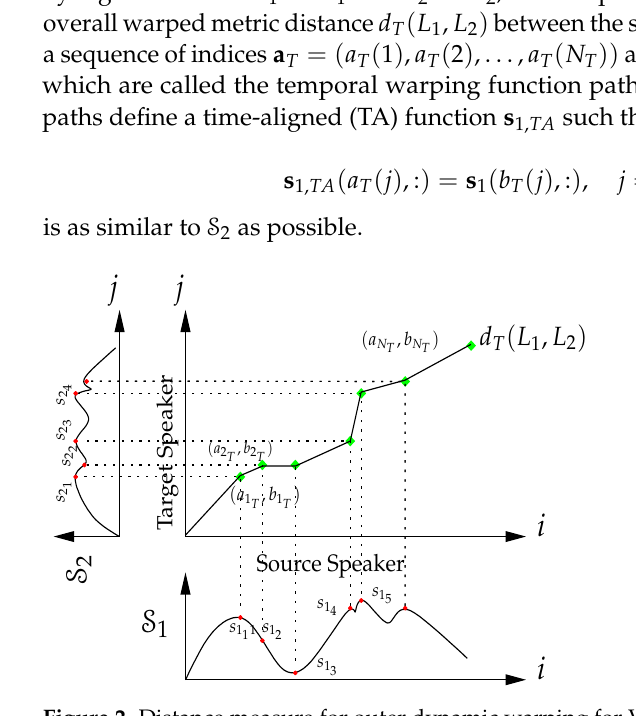
Figure 2. Distance measure for outer dynamic warping for VT. The distance between two feature vectors in (2), d ( s 1 ( (cid:96) 1 , : ) , s 2 ( (cid:96) 2 , : )) , can itself be computed using warping between the components of these individual vectors. Because these vectors represent frequency information, this is DFW. DFW is computed in a way similar to the DTW. Let s i = s i ( (cid:96) i , : ) , i = 1, 2 denote the spectral information vectors at segment (cid:96) i that is passed to the DFW function from the (outer) DTW function. The elements of s i are denoted by s i ( k ) . DFW is applied to calculate the distance between s 1 and s 2 as d F ( k 1 , k 2 ) = dist ( s 1 ( k 1 ) , s 2 ( k 2 ))+ min { d F ( k 1 − 1, k 2 ) , d F ( k 1 , k 2 − 1 ) , d F ( k 1 − 1, k 2 − 1 ) } , (3) where the subscript F refers to a frequency (or spectral) warping process, and dist ( s 1 ( k 1 ) , s 2 ( k 2 )) represents the metric distance between elements of the feature spectral